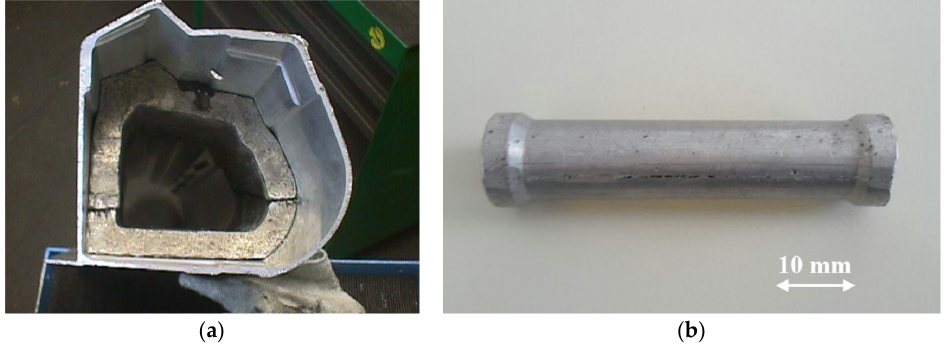
Figure 4. ( a ) Al ‐ foam part for the Ferrari 360 and 430 spider; and ( b ) small crash ‐ absorbing element for the Audi Q7 (courtesy of Alulight).